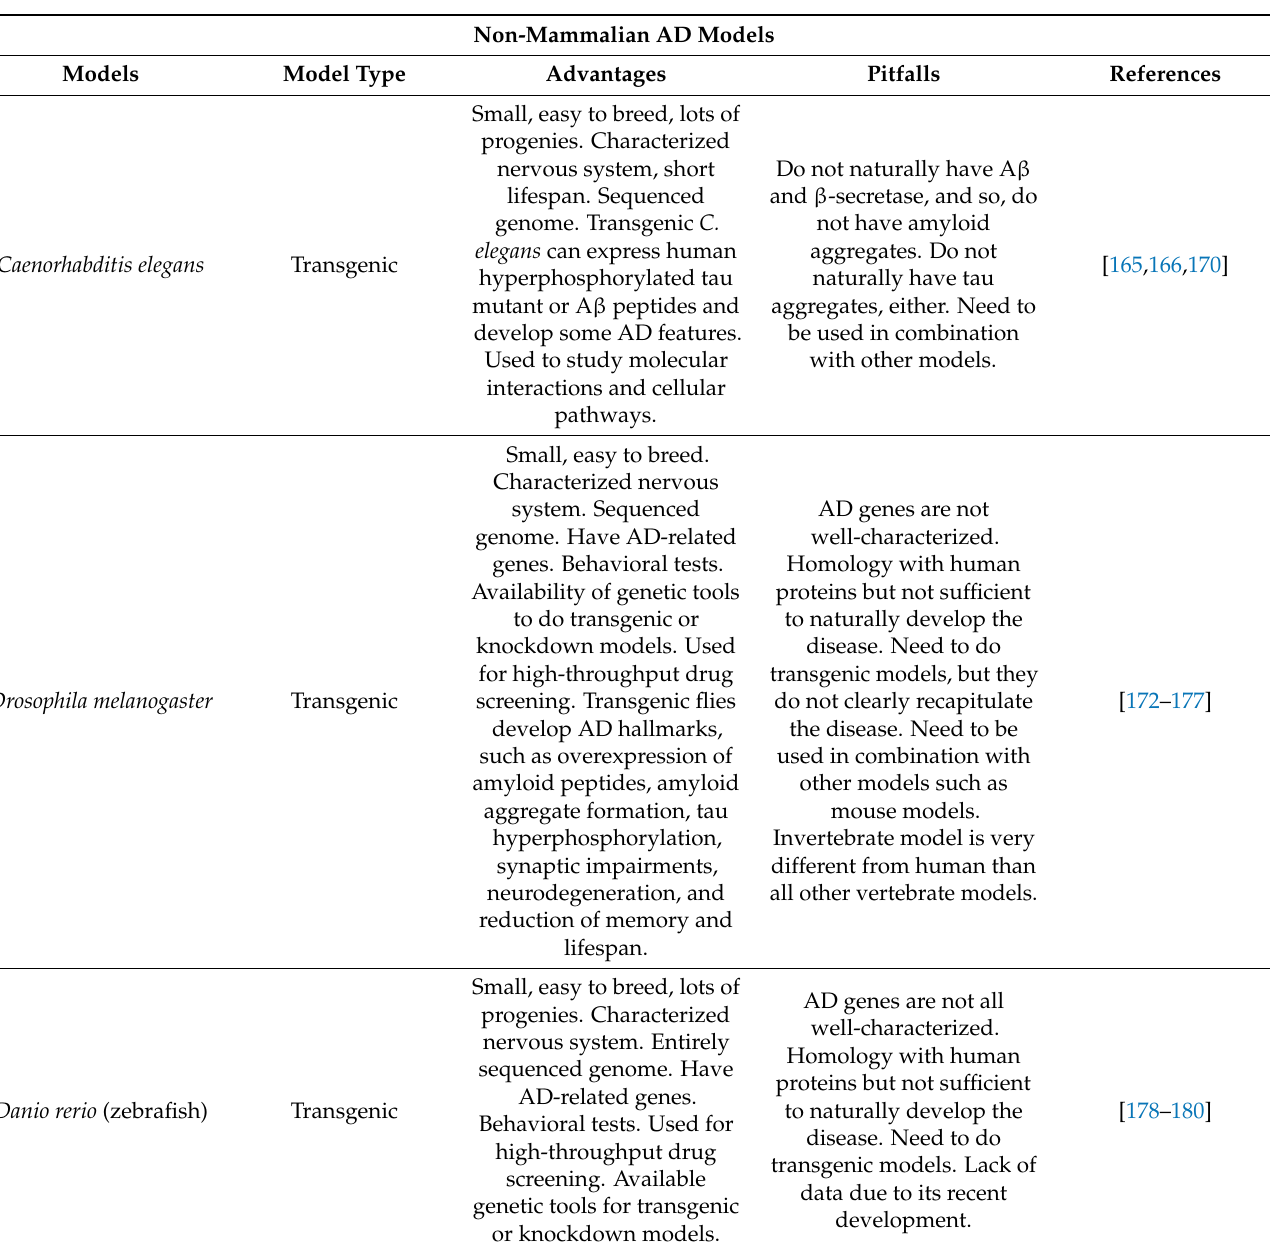
Table 5. In vivo AD models in non-mammal